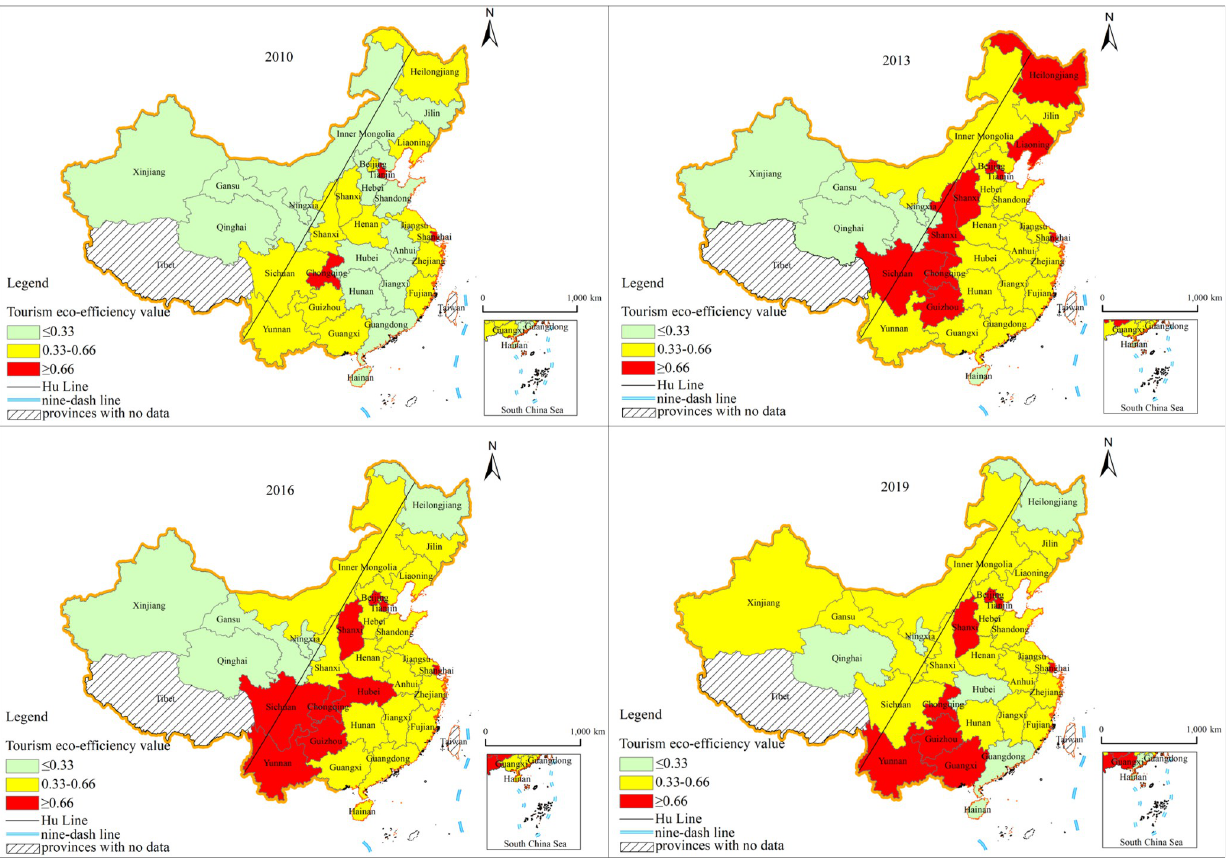
Fig 3. Values of tourism eco-efficiency in China provinces in 2010, 2013, 2016 and 2019 years. (This map is based on the standard map with review number GS(2019)1697 downloaded from the Ministry of Natural Resources Standard Map Service website (http://bzdt.ch.mnr.gov.cn), and the base map has not been